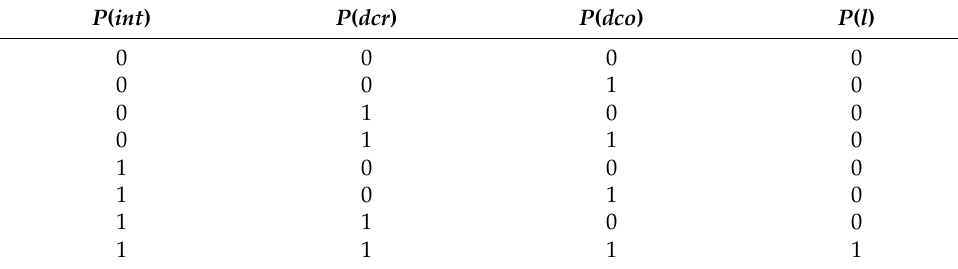
Table 1. Logical binary relationship for the probability of